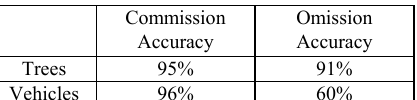
Figure 5: Feature relevance results of Contribution Ratio and Random Forests for dataset Enschede.